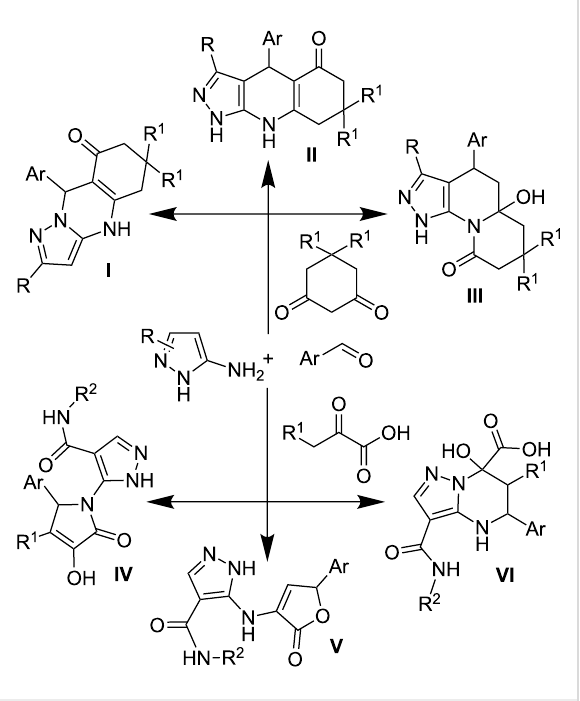
Figure 1: Some MCRs of aminoazoles with controlled switching of the direction.